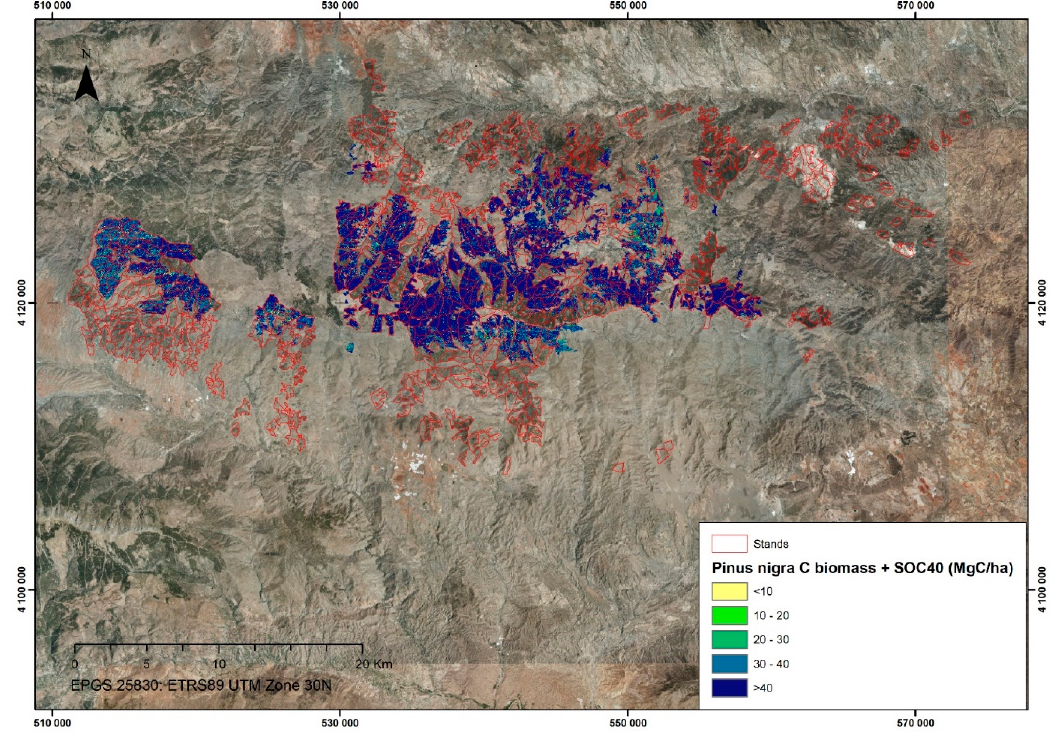
Figure 5. Cartography of the C stocks in Pinus nigra plantations at Sierra de los Filabres (Southern Spain).